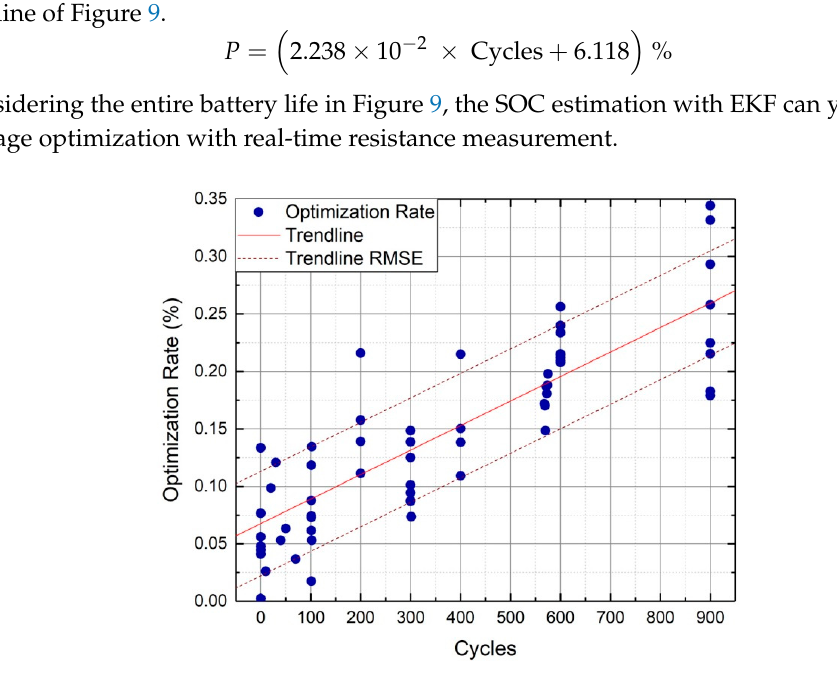
Figure 9 . The optimization rate of SOC estimation with online internal resistance. Figure 9. The optimization rate of SOC estimation with online internal